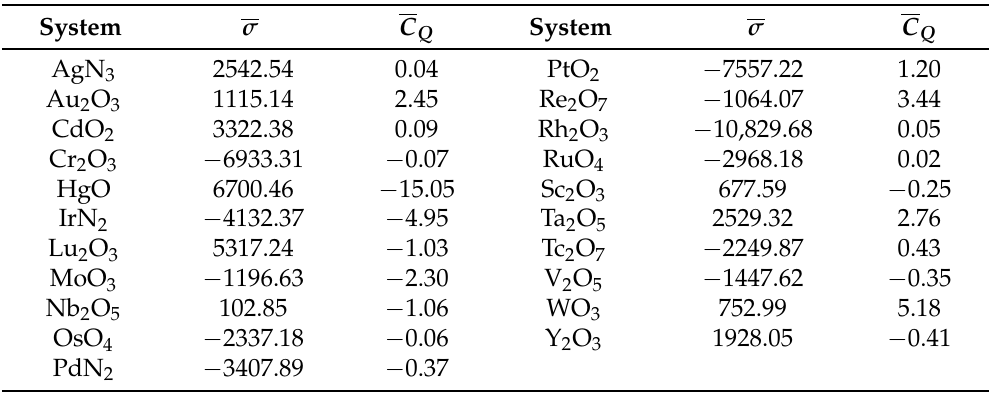
Figure 1. Lattice parameters of 21 fully relaxed unit cells with developed GIPAW pseudopotentials (red circles) compared with those optimized with PAW pseudopotentials in VASP code (cyan squares) and experimental ones (black crosses). Table 1. Average of total chemical shift σ in ppm and the average of quadrupolar coupling constant C Q in MHz for each d element within their oxides or